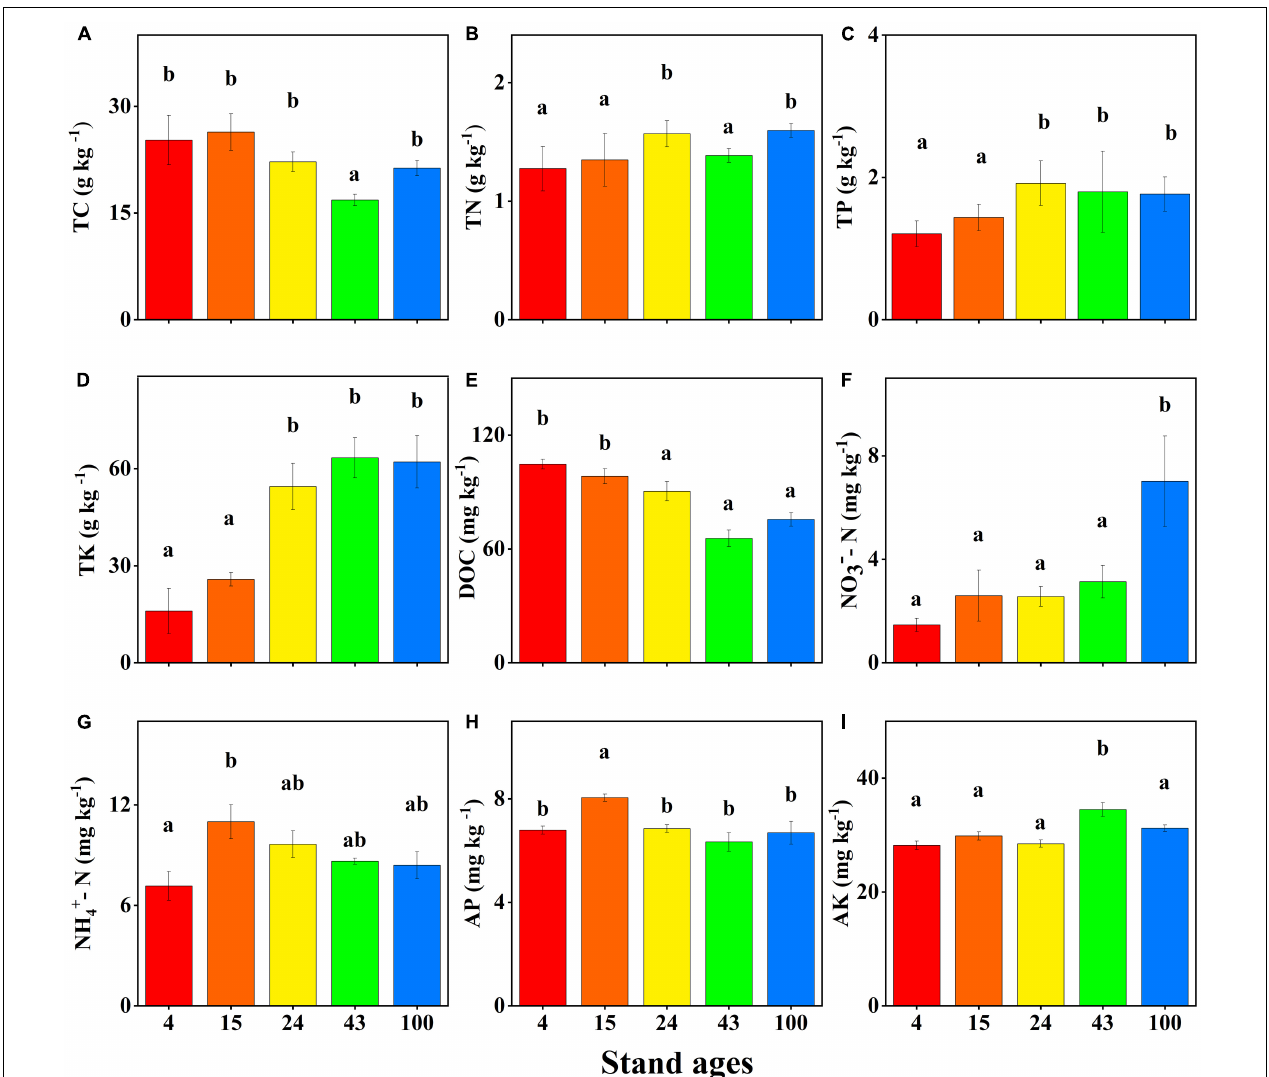
FIGURE 1 | Soil nutrient concentrations in different stand ages (years) of Chinese fir plantations (mean ± SE, n = 3). Total carbon (TC) (A) , total nitrogen (TN) (B) , total phosphorus (TP) (C) , total potassium (TK) (D) , dissolved organic carbon (DOC) (E) , nitrate-nitrogen (NO 3 − -N) (F) , ammonium-nitrogen (NH 4 + -N) (G) , available